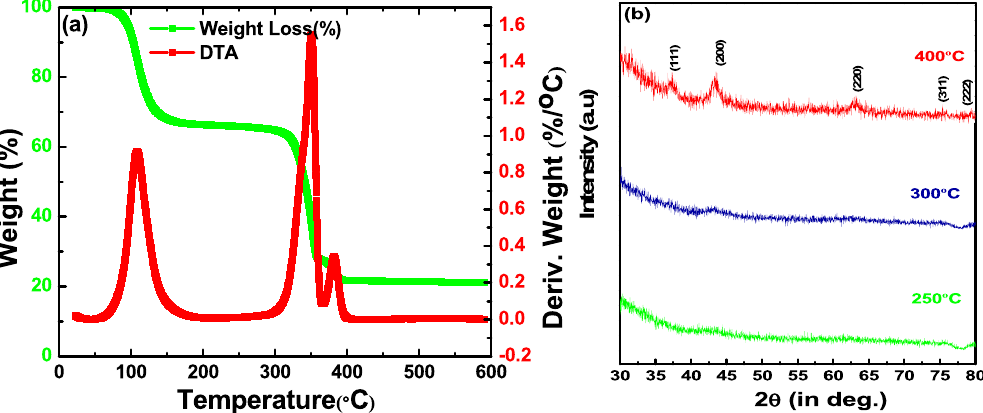
Figure 4. ( a ) Thermogravimetric (TGA) analysis of nickel oxide precursor ink used for printing of NiO thin films and ( b ) XRD spectra of printed NiO films on glass substrates heat treated at different temperatures for one